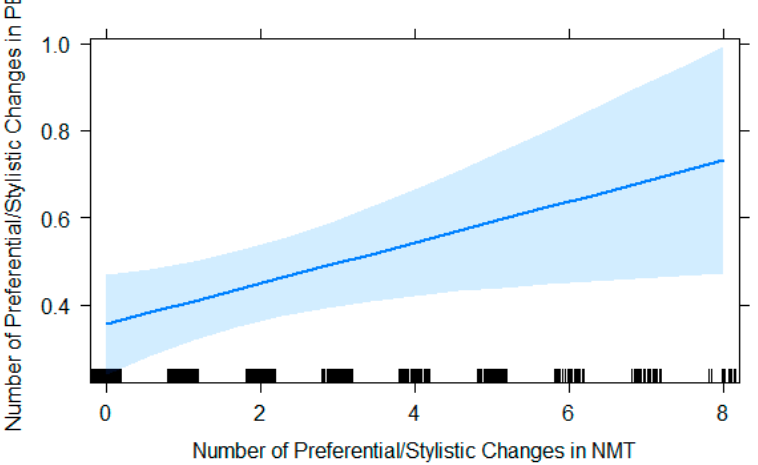
Figure 3. Effect of register errors in NMT on register errors in NMTPE.